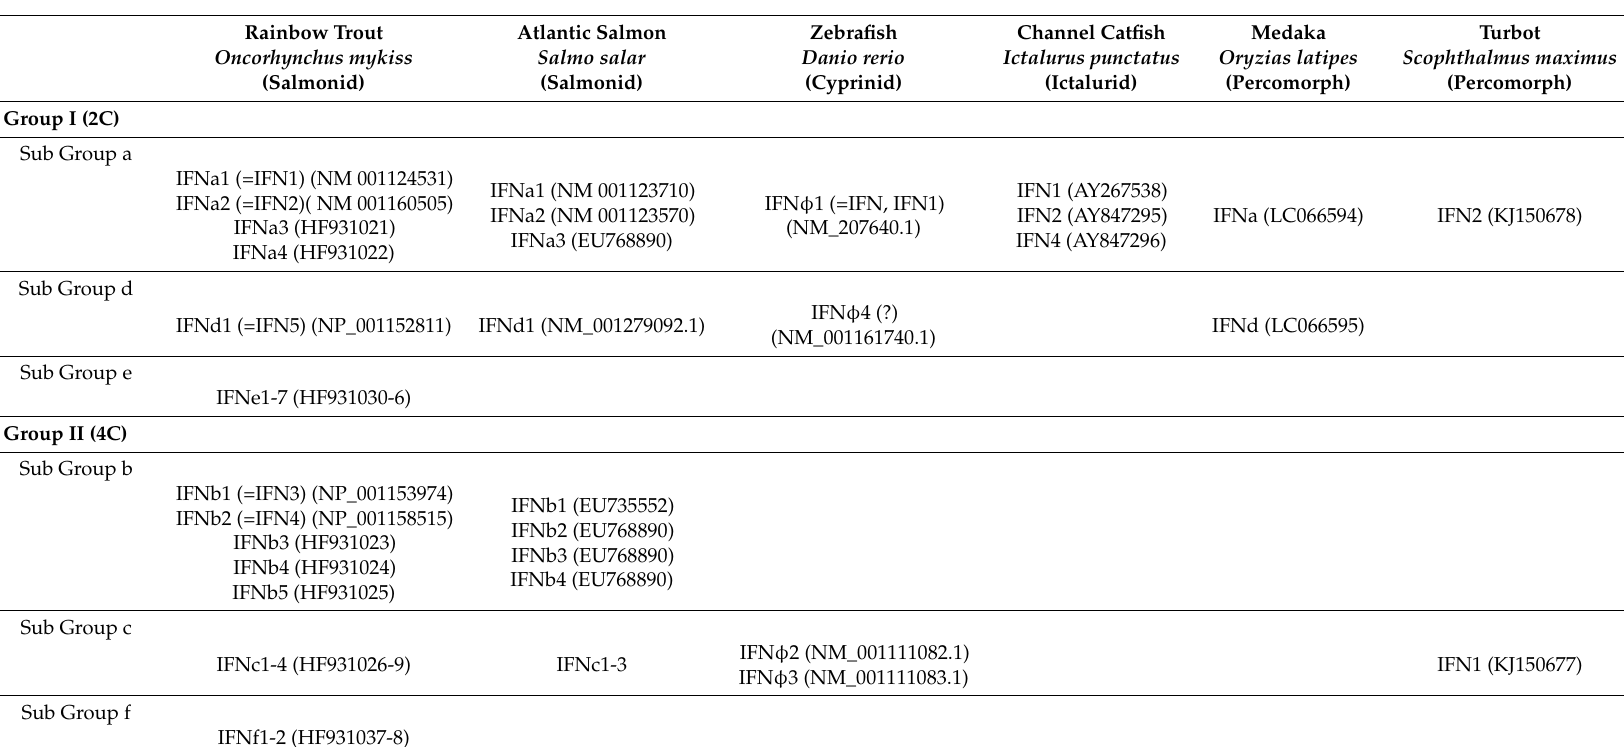
Table 1. Phylogenetic relationships between fish type I interferons (IFNs); from